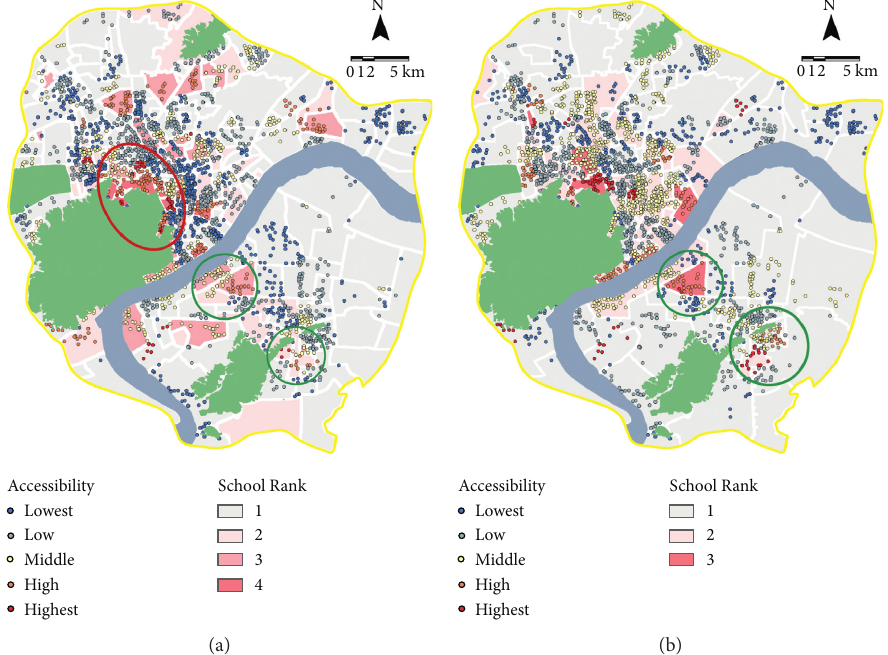
Figure 3: The distribution of education accessibility in Hangzhou with classic G2SFCA. (a) Primary school. (b) Secondary school.